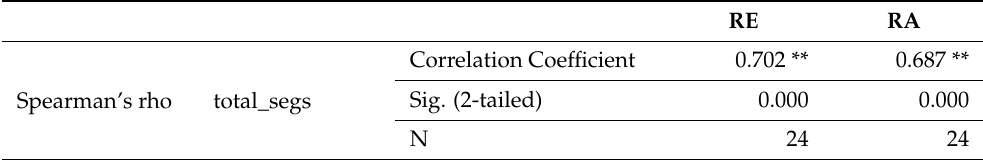
Table 3. Correlations.